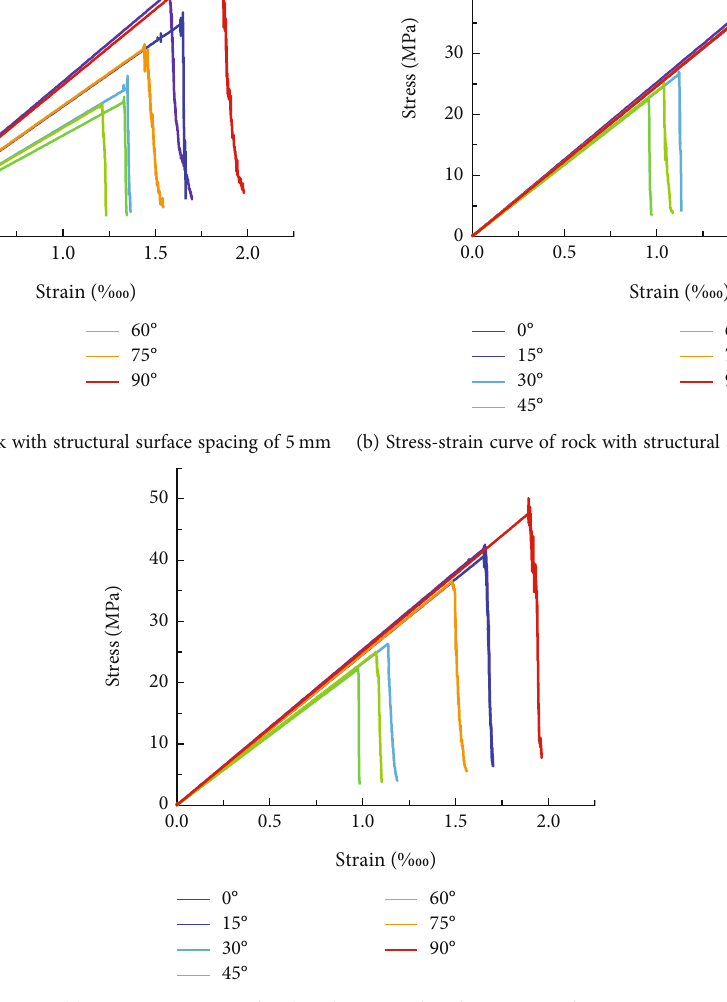
Figure 14: Mechanical properties of rock mass under di ff erent joint spacing